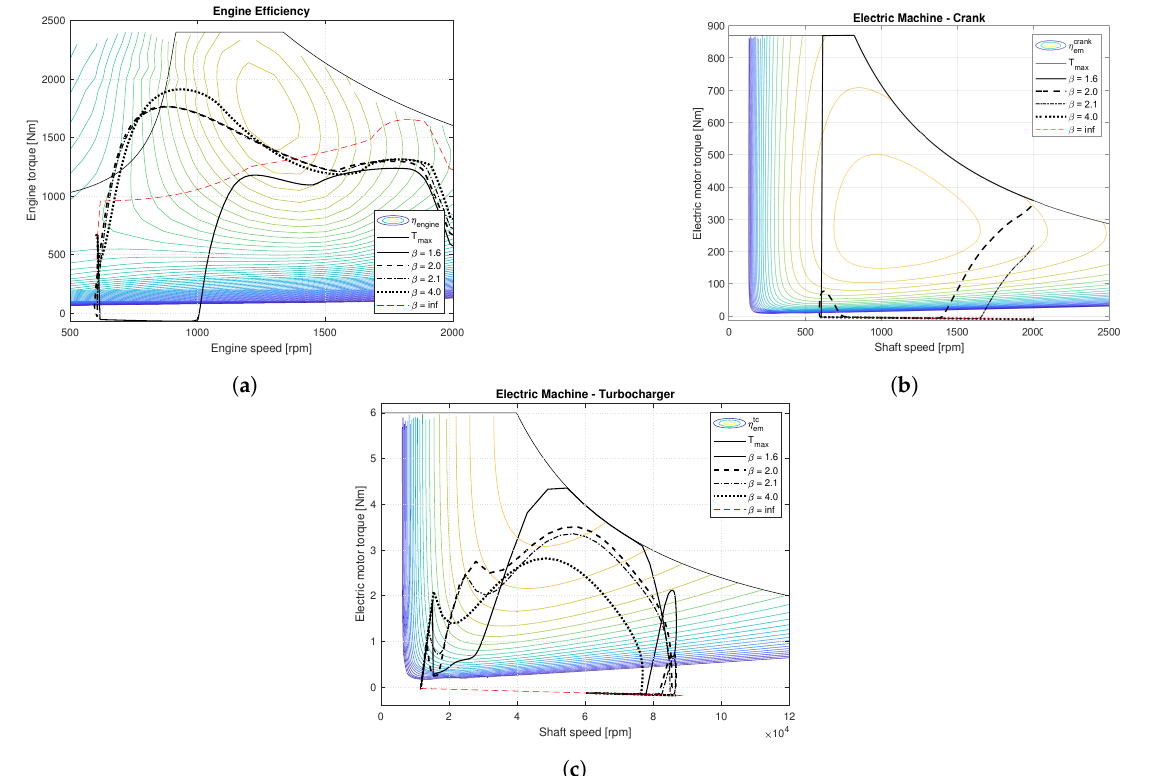
Figure 11. Solution characteristics when using a combustion engine, a crank shaft electric motor and a turbocharged electric motor. The legends display the cost factors ( β ) for the different solutions. ( a ) Diesel engine utilization during an optimal fuel acceleration with E-crank and E-turbo. ( b ) Utilization of the E-crank during the acceleration. When β = inf, the torque output is lower than 0 during the acceleration due to the electric motor friction. ( c ) Utilization of the E-turbo during the acceleration. When β = inf, the electric motor torque is negative due to friction.